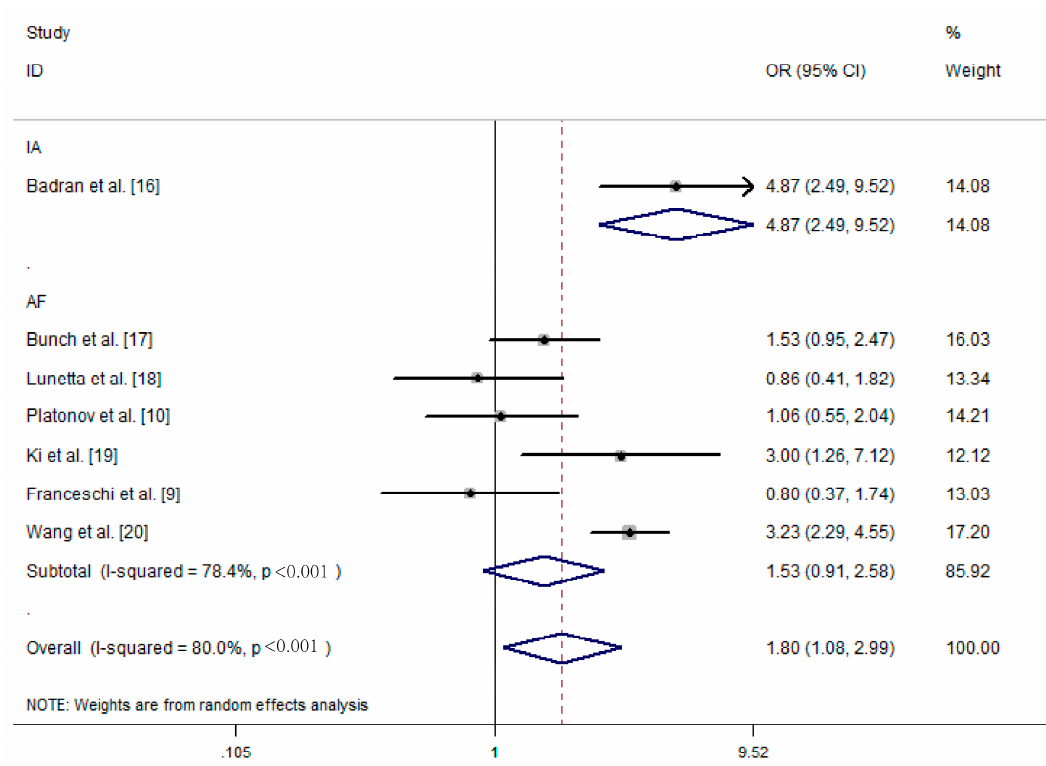
Figure 3. Forest plot showing the relationship between arrhythmia and Helicobacter pylori infection: studies divided into subgroups according to the type of arrhythmia. OR, odds ratio; CI, confidence interval.